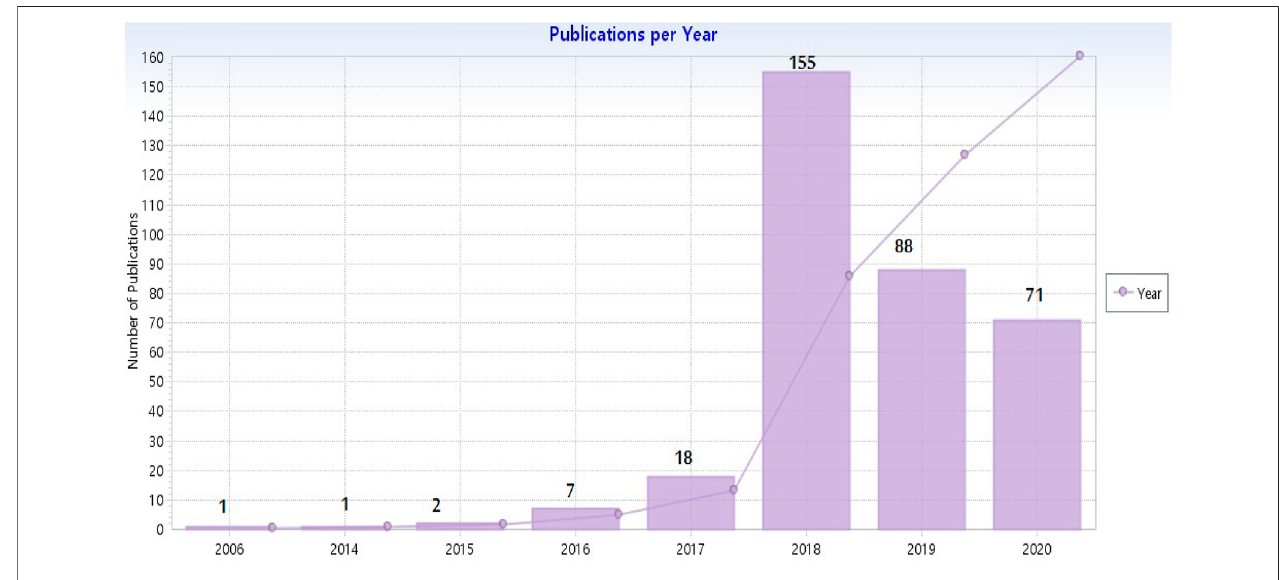
FIGURE 1 | Publications per year.